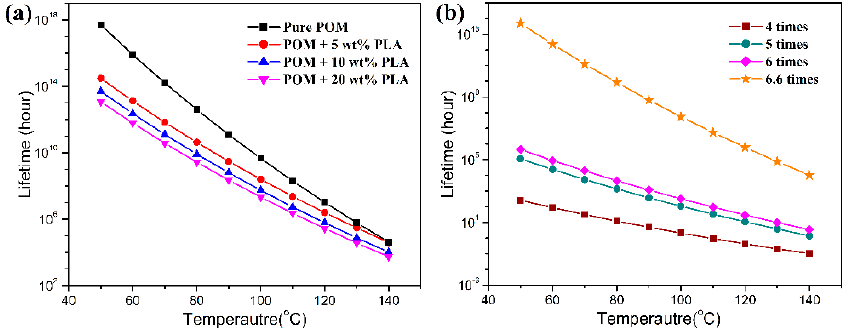
Figure 16. Plots of lifetime as a function of temperature for ( a ) pure POM fiber and POM/PLLA bicomponent fibers at the ultimate draw ratio, and ( b ) POM/PLLA bicomponent fiber containing 10 wt % PLLA at different draw